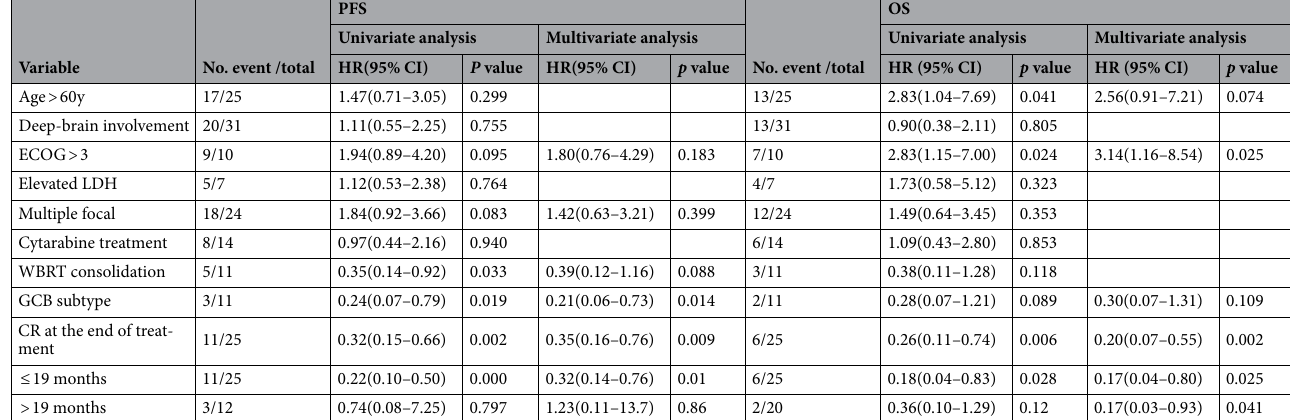
Table 3. Univariate and multivariate analyses of overall and progression-free survival. Notes CI, confidential interval; CR, complete remission; HR, hazard ratio; ECOG, Eastern Cooperative Oncology Group; GCB, germinal center B-cell-like; LDH, lactate dehydrogenase; OR, overall remission; OS, overall survival; PFS, progression-free survival.